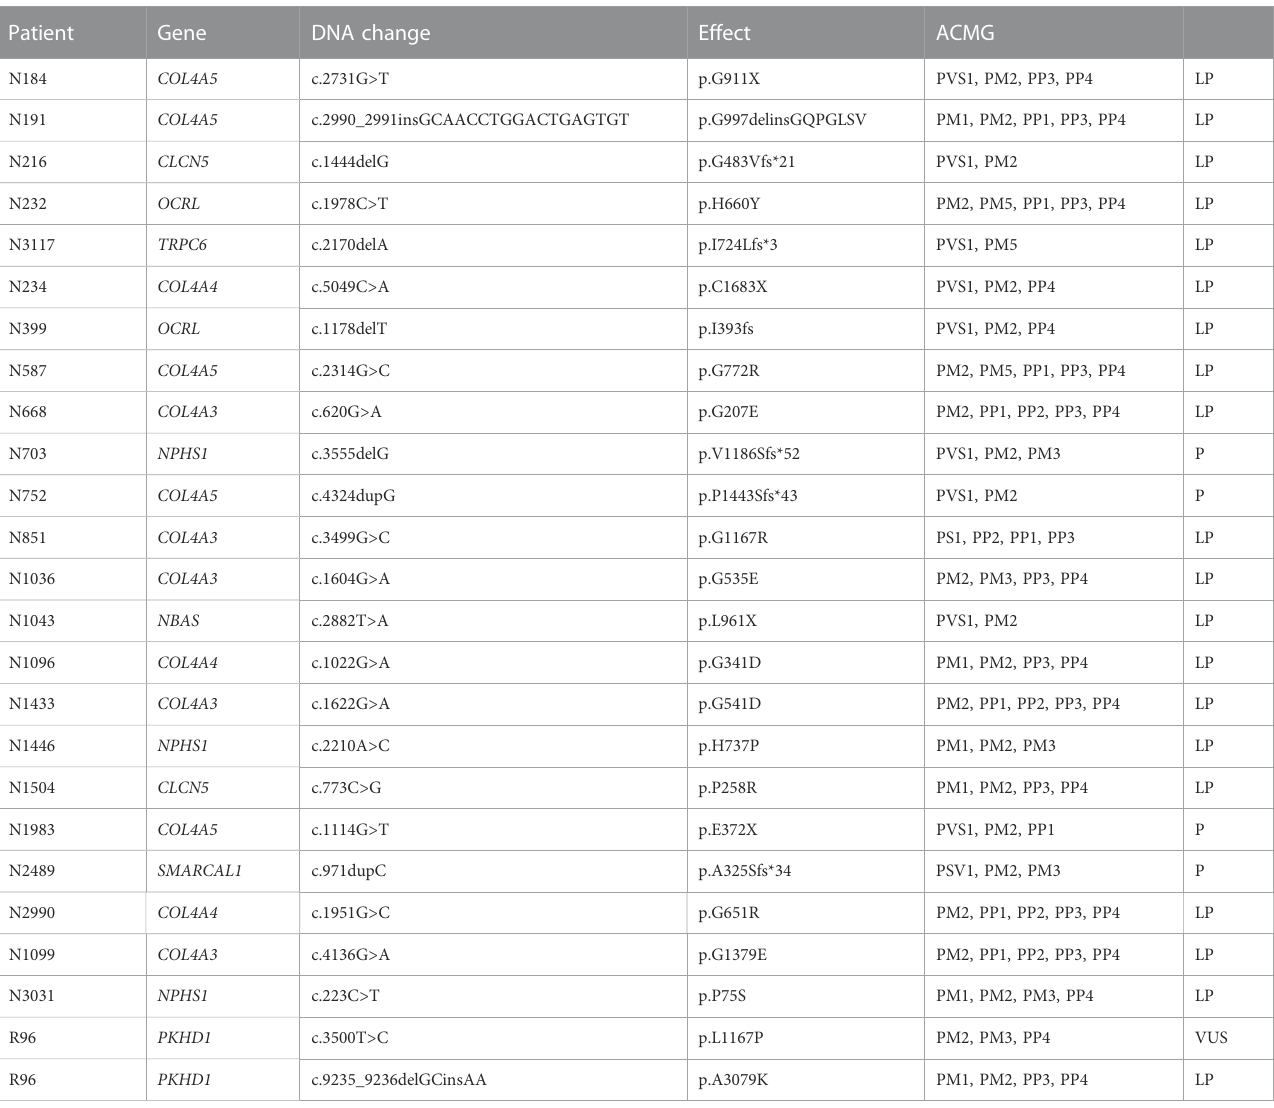
TABLE 3 Evaluation of novel variants according to the ACMG guidelines. Patient